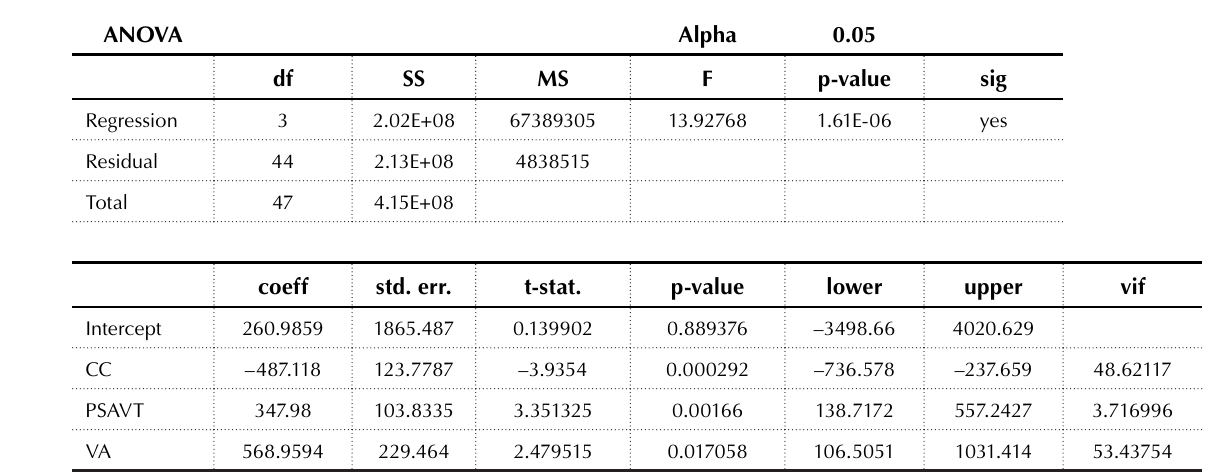
Table 7. Stepwise regression